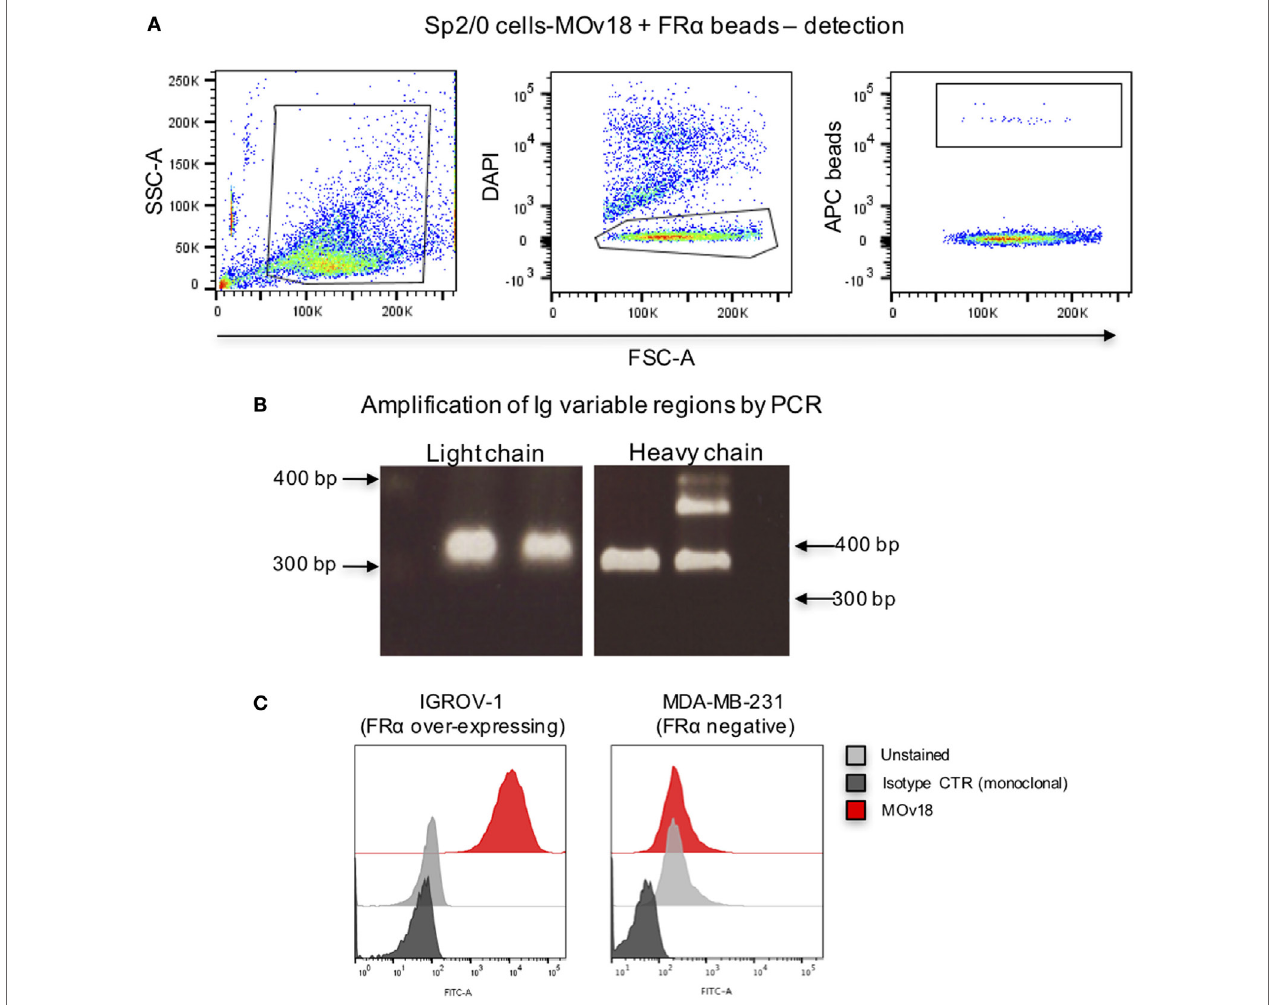
FigUre 3 | Binding of folate receptor α+ beads to B cells expressing MOv18 antibody. (a) Gating strategy for Sp2/0 cells (10 5 in 100 µl FACS buffer) expressing MOv18 IgG, incubated with fluorescent LumAvidin 5.6 µm microspheres coated with FR α via PEG12-biotin. Single live cells binding to the beads were sorted into individual wells in a 96-well plate. (B) Agarose electrophoresis of the heavy and light chain variable regions of immunoglobulin sequences obtained from the Sp2/0 cells and amplified by PCR. (c) Flow cytometric evaluations of purified MOv18 antibody, produced in-house from single Sp2/0 cell Ig sequences, and expressed as a human/chimeric IgG1. MOv18 recognized FR α -overexpressing IGROV1 cancer cells but not FR α -negative MDA-MB-231 breast cancer cells. Dark gray histogram: unstained IGROV1 cells; light gray histogram: non-specific anti-NIP (monoclonal) antibody alone; Red histogram: MOv18 antibody cloned from a single B